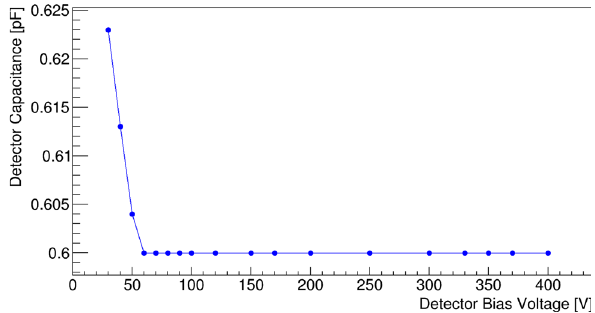
Fig. 9 Measured detector capacitance as a function of bias voltage at 79 K for detector USD-W06. The full depletion voltage of the detector was determined to be 60 V since the detector capacitance became a constant after the detector was fully